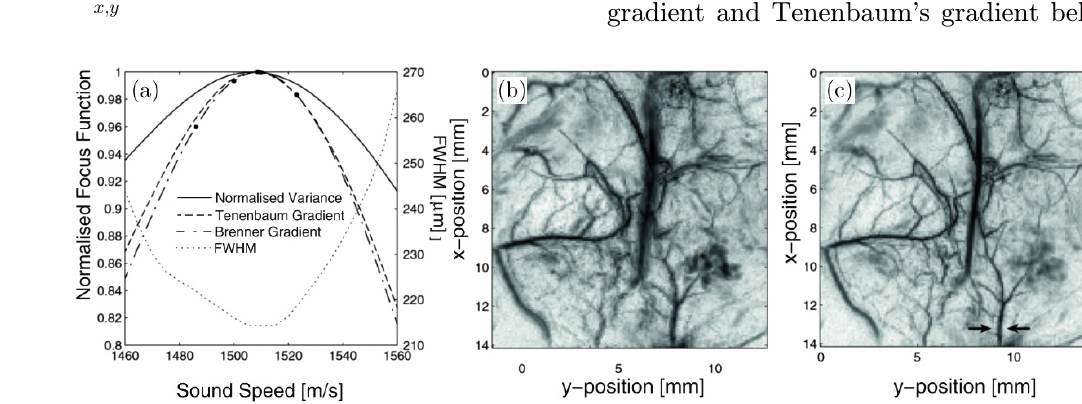
Fig. 5. Image enhancement by the autofocus method. (a) Three investigated focus metrics give the same value for the optimum SOS. (b) Defocused image reconstructed using an SOS overestimated by 5%. (c) Focused image reconstructed using the optimized SOS. Reproduced with permission from Ref.